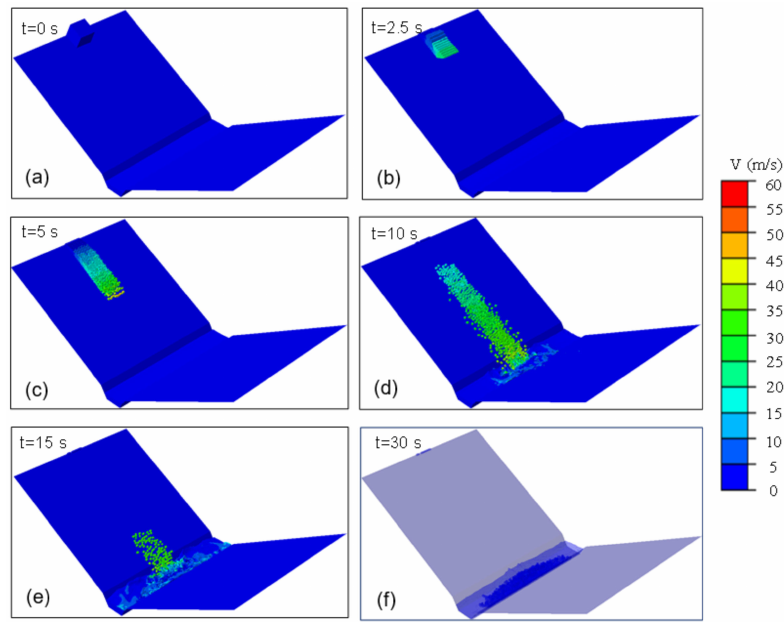
Figure 8. The whole process of rock avalanche river-blocking, based on the contour velocity map: ( a ) initial state of the model; ( b ) rock blocks collapse; ( c ) runout behavior; ( d ) sliding mass reaching the river; ( e ) induced wave behavior; ( f ) formation of a landslide